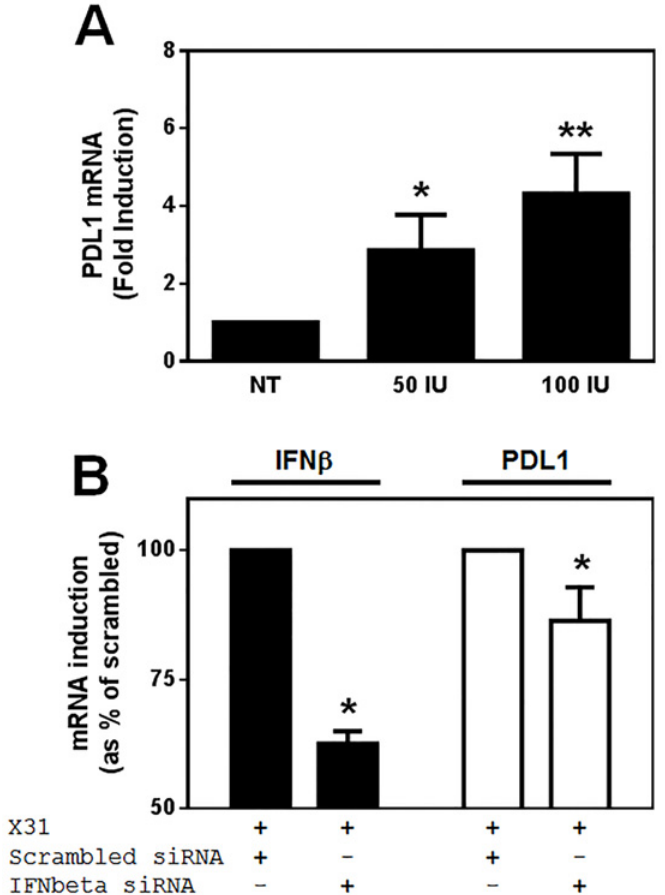
Fig 7. Regulation of PDL1 mRNA expression by influenza infection and IFN β . A) PDL1 gene expression was assessed in MDM differentiated in the presence of 2 ng/ml GM-CSF for 12 d before incubation with the indicated doses of rhIFN β for 24 h using RT-PCR (n = 5). B) MDM were differentiated in the presence of 2 ng/ ml GM-CSF for 11 d before transfection with non-specific siRNA or siRNA specific for IFN β in the presence of GM-CSF for 24 h. MDM were then infected with 500 pfu/ml of H3N2 X31 influenza virus or a UV-irradiated aliquot of virus (UVX31) for 2 h. After washing, media was replaced and the cells incubated for a further 22 h before cells were harvested for RT-PCR analysis of IFN β and PDL1 mRNA expression (n = 6). PCR data were normalised to β 2MG and are expressed as mean fold induction over the non-infected (NI) sample ± SEM of n independent experiments. Data analysed using a paired t-test * p < 0.05, ** p <